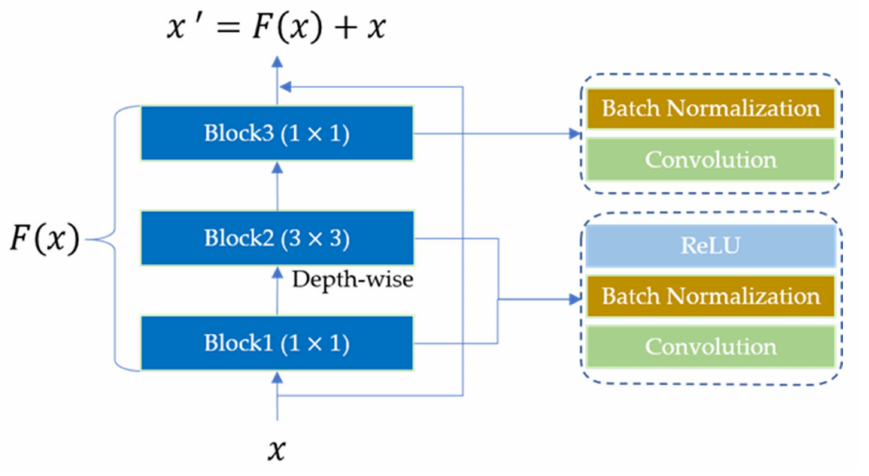
Figure 1. Inverted residual block in